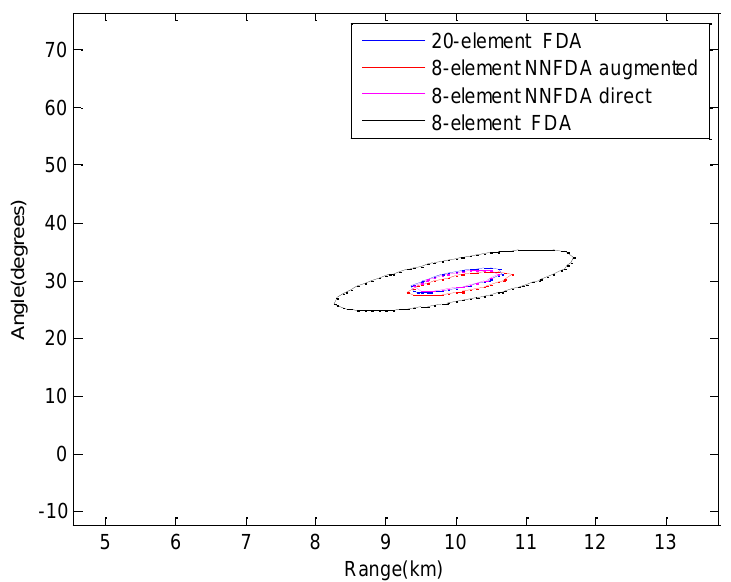
Figure 5. − 3dB sectional areas of the normalized